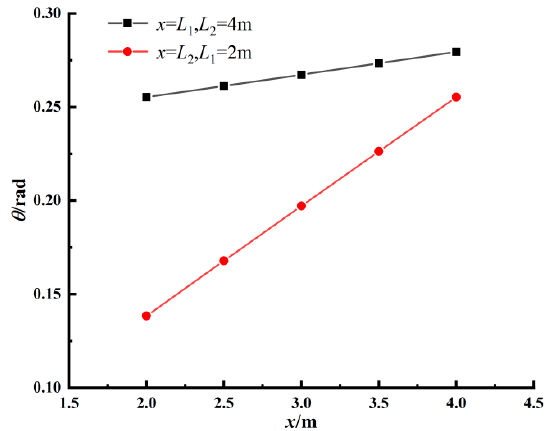
Figure 7. The value of the central angle θ for different L 1 , L